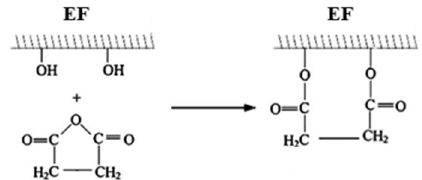
Figure 3. Maleic anhydride treatment of eucalyptus fibers.